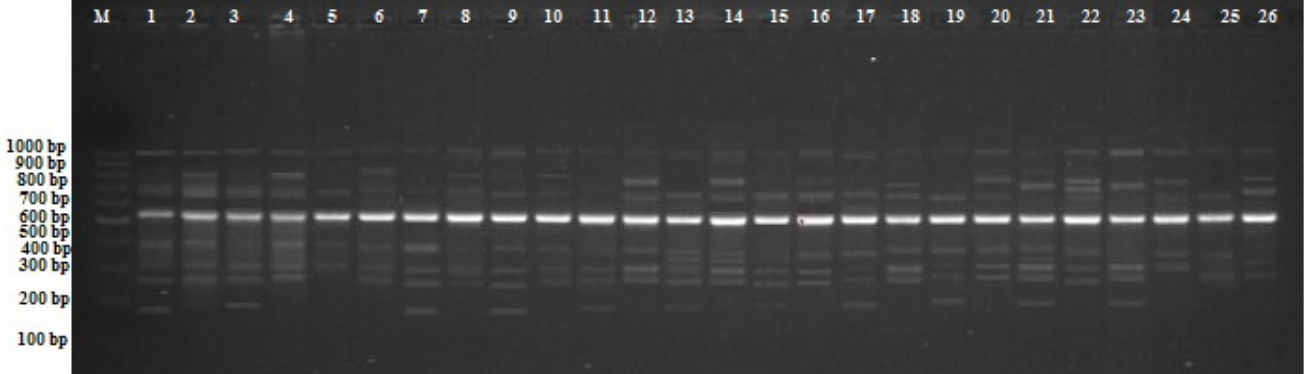
Figure 2. CRED ‐ RA profiles for various experimental groups with OPH ‐ 17 primers in bean. M; 100– Figure 2. CRED-RA profiles for various experimental groups with OPH-17 primers in bean.